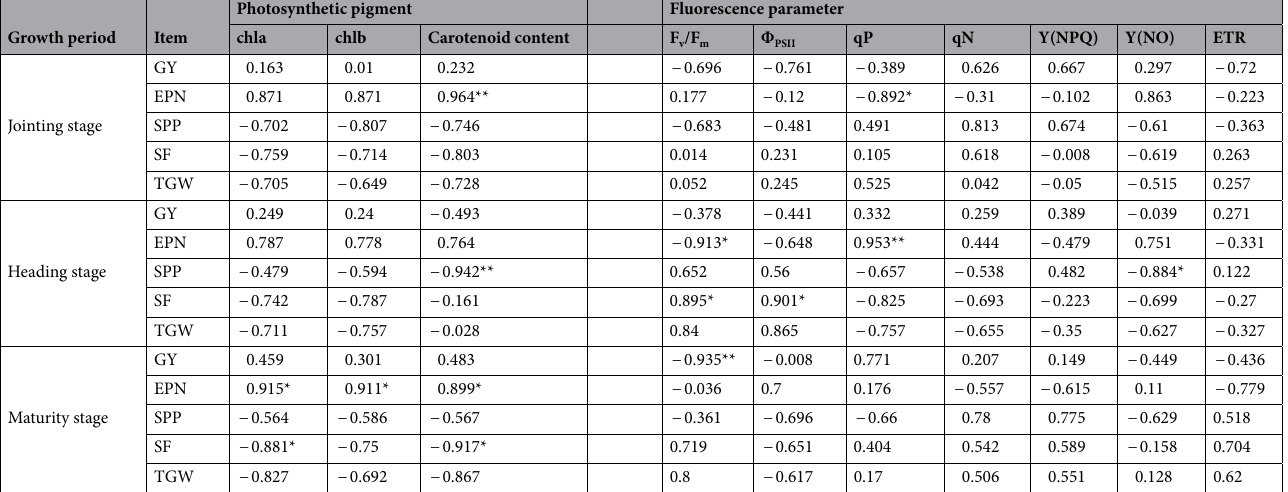
Table 3. Relationship between rice yield and its components, photosynthetic pigments, and fluorescence parameters. Note GY, grain yield; EPN, effective panicle number; SPP, spikelets per panicle; SF, seed setting rate; TGW, thousand-grain